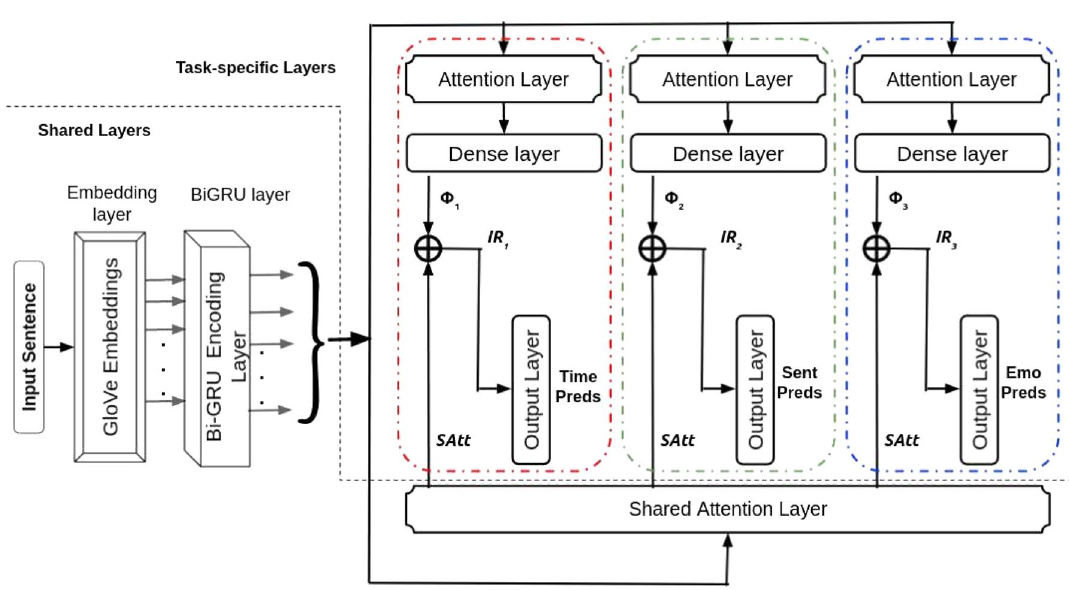
Figure 5. Architecture of shared-private attentive network without multi-layer cascades. Colour coded red, green and blue dotted lines depicts the three independent